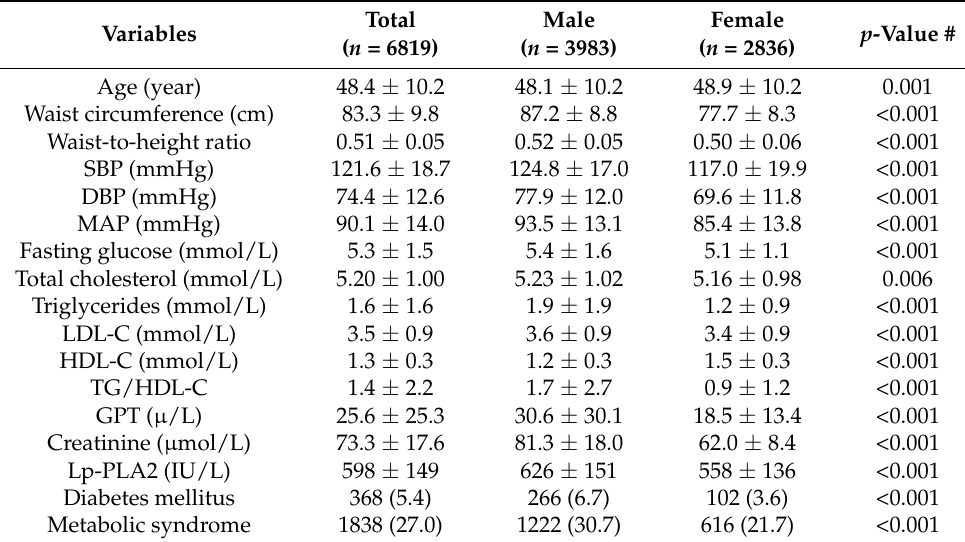
Table 1. Basic characteristics of the study